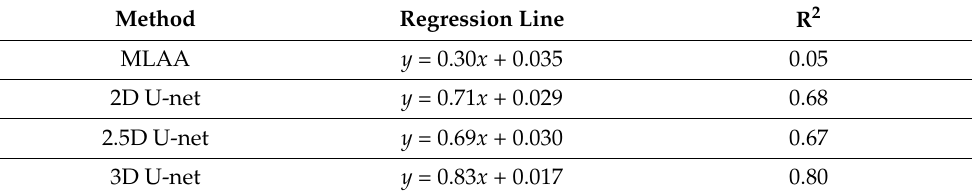
Table 2. Voxel-wise correlation coefficients with the CT-derived µ -map ( µ -CT).